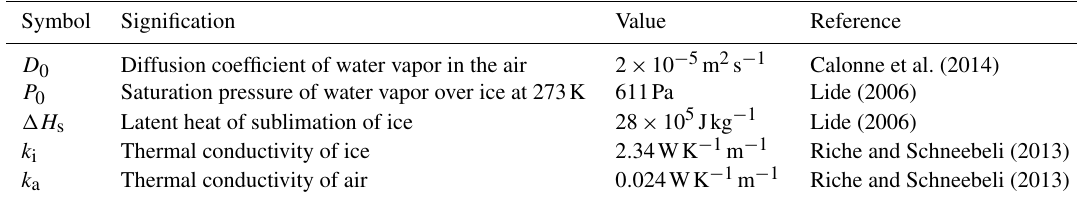
Table D1. Physical constants used in the